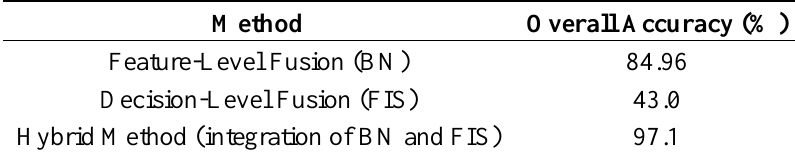
Table 7. Comparison of multi-layer fusion techniques’